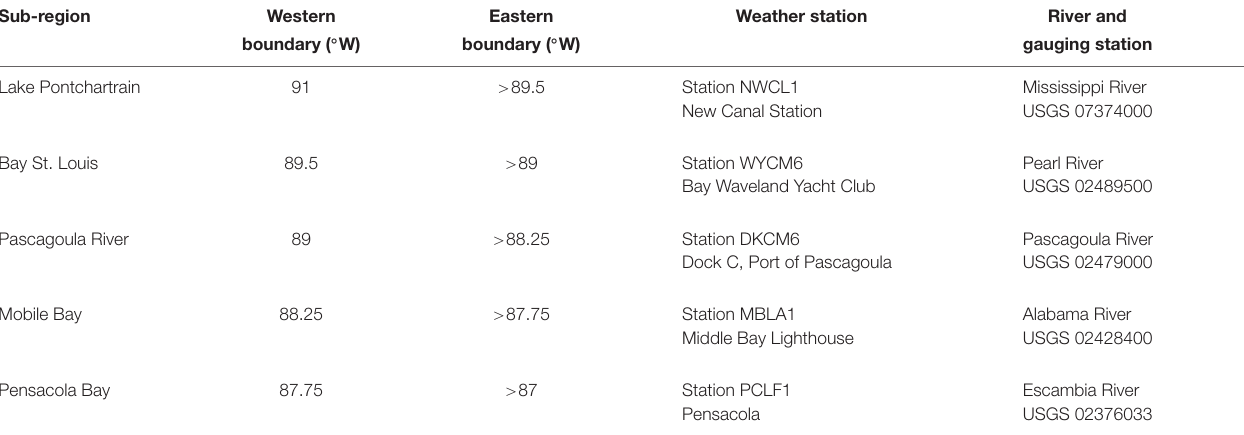
TABLE 2 | Weather and gauging stations for longitudinally defined sub-regions within the study area.